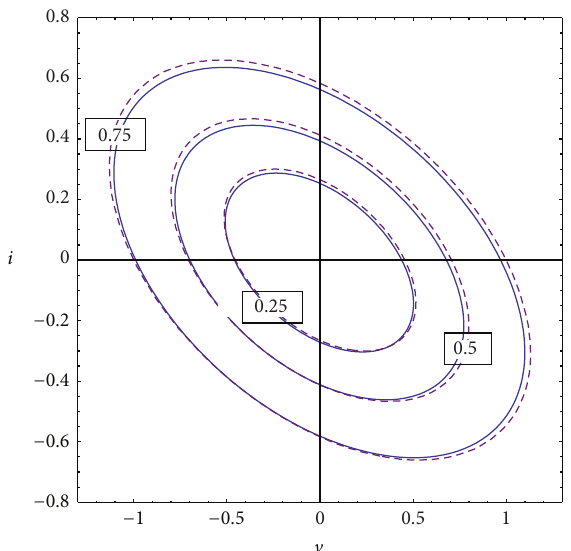
Figure 4: Ellipsoid quartiles of the rescaled data obtained from the simulations of the epidemic model with immunization ( blue ) and the 25 %, 50 %, and 75 % contours of the asymptotic bivariate normal density ( purple dashed lines ).